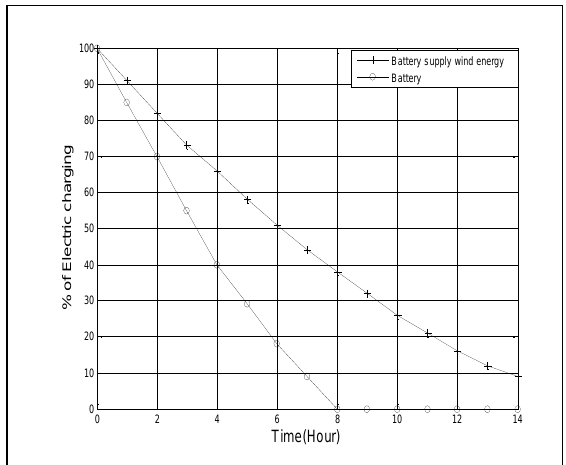
Figure 5. Unloading batteries for our model and existing